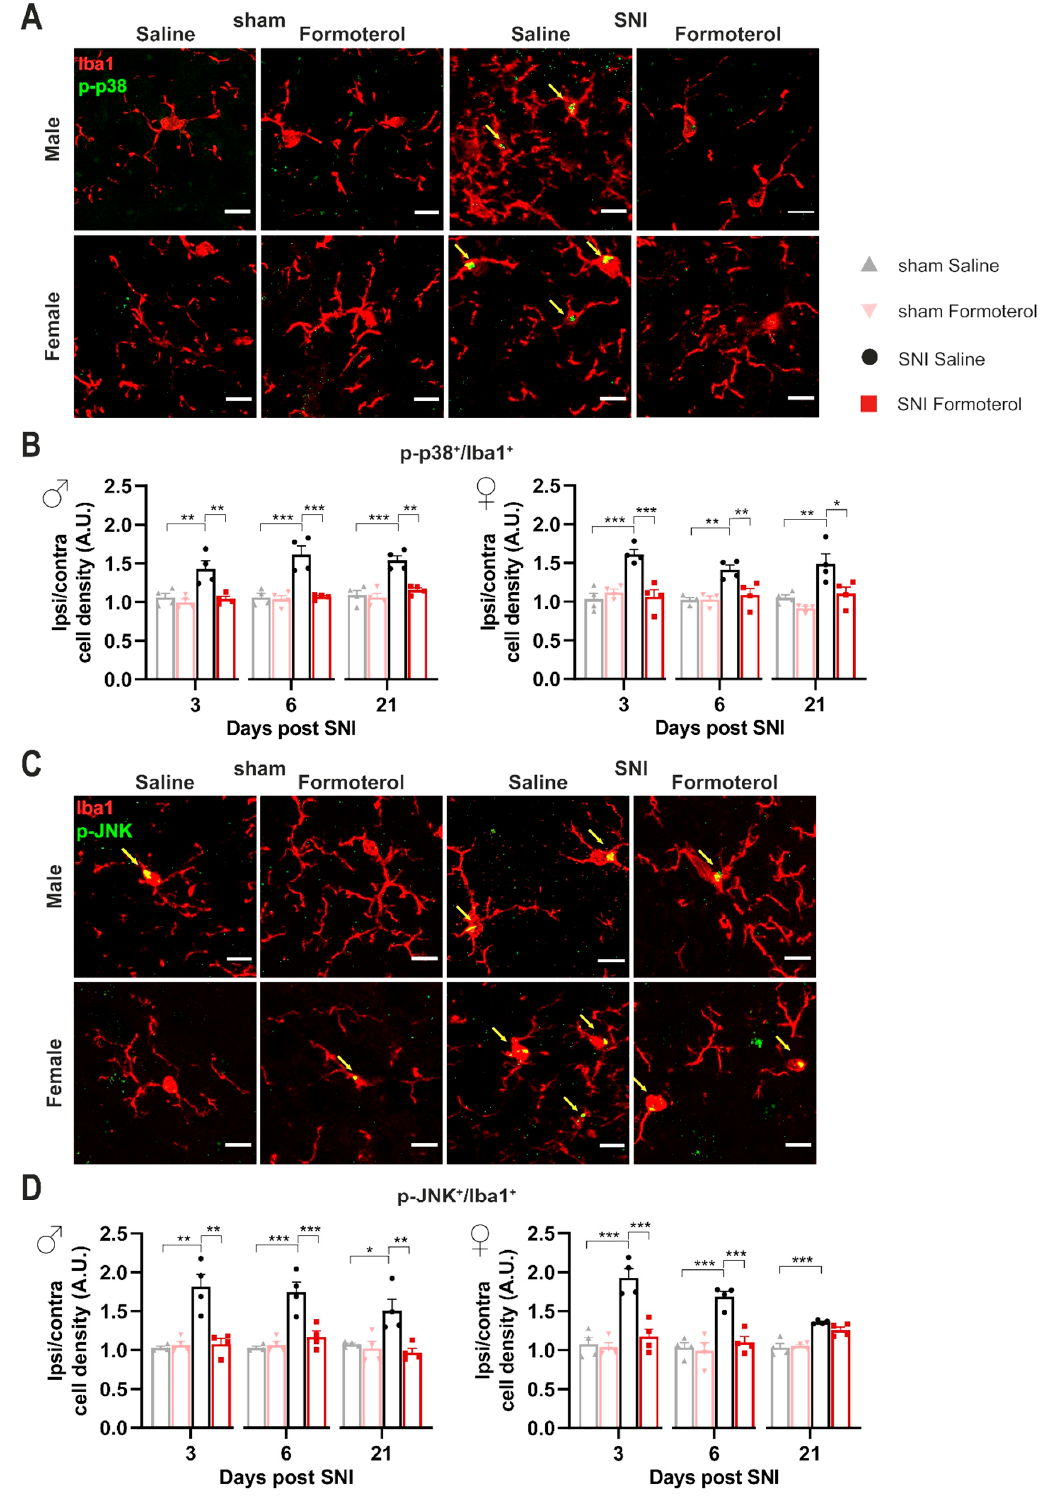
Figure 4. Formoterol weakens microglial activation markers in the spinal dorsal horn of SNI- operated mice. ( A ) Representative examples of colocalization of Iba1-positive signal and the microglial activation marker p-p38 in the spinal dorsal horn (SDH) in male and female mice, six days after operation injected with saline or Formoterol. Double-positive cells are pointed by arrows.